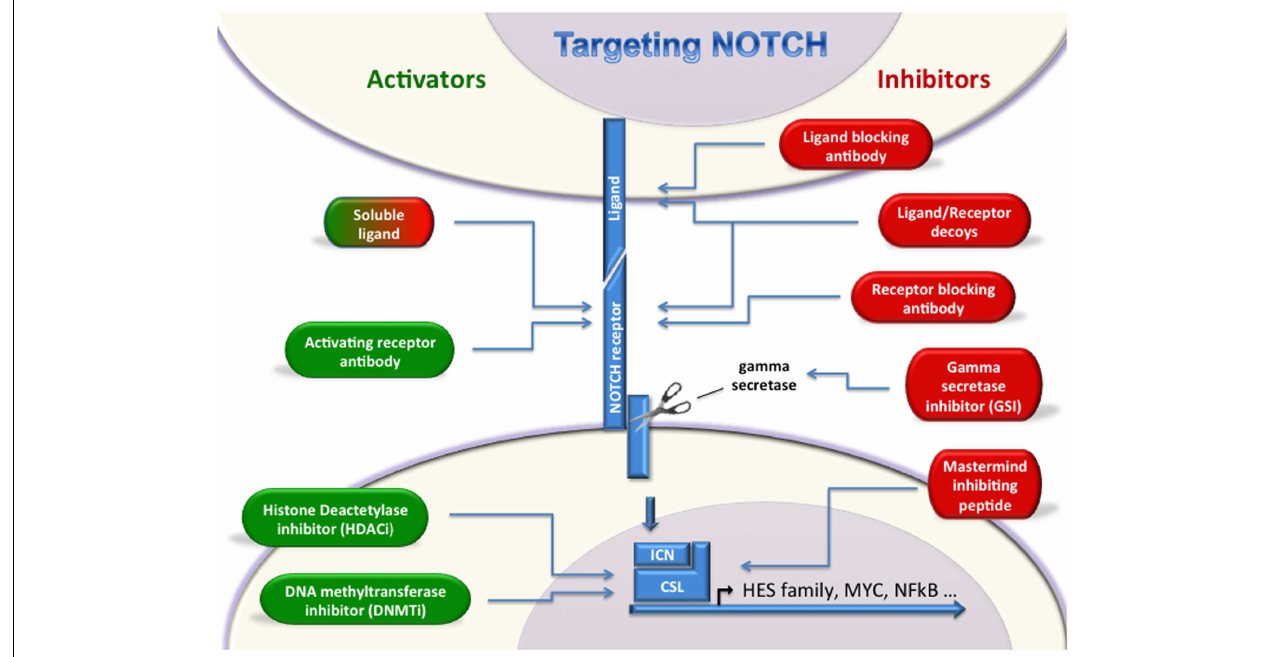
FIGURE 1 |Targeting Notch. Multiple strategies for either activating or inhibiting Notch have been described. Notch activators (green, left) and Notch inhibitors (red, right) will allow modulation of Notch depending on oncogenic or tumor suppressor roles in a given cancer type. Soluble ligands can either activate or inhibit Notch